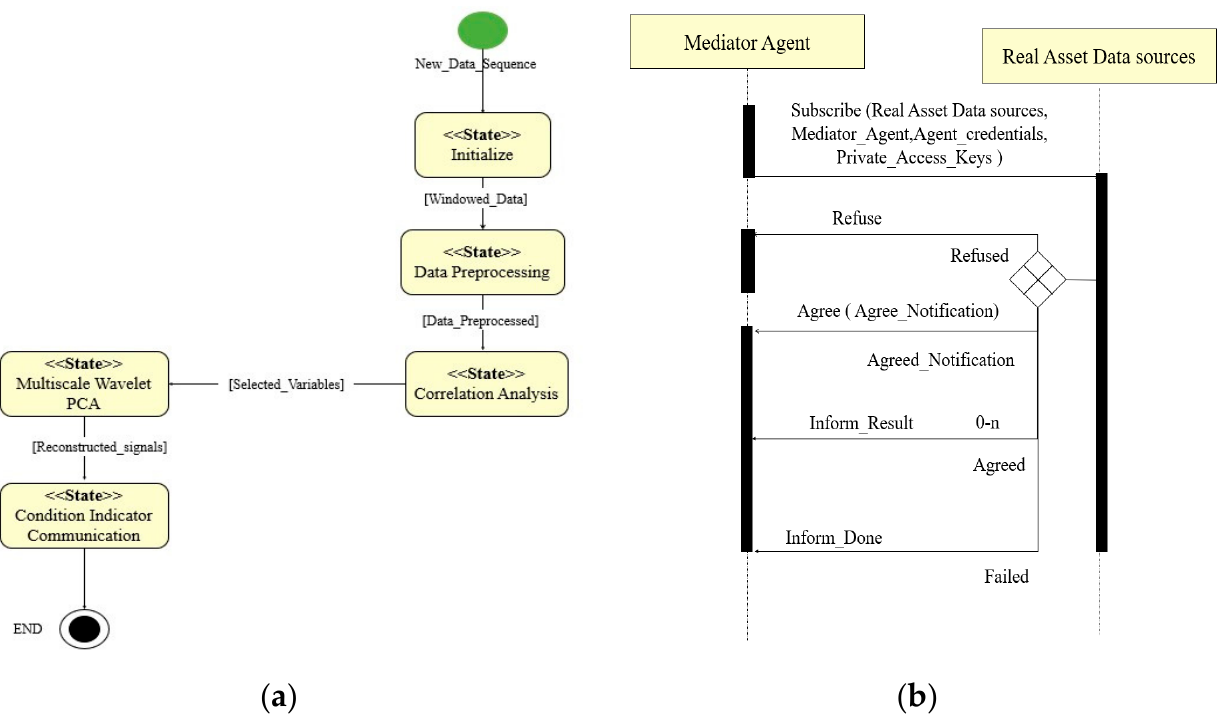
Figure 8. Plan model for features extraction and selection capabilities ( a ). Protocol model for mediator agent and physical twin interaction ( b ) .